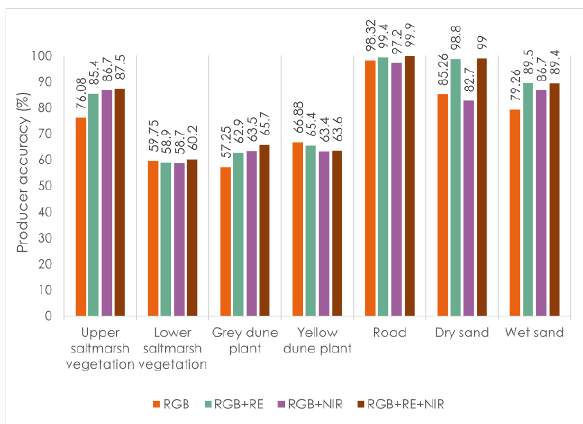
Figure 10. Barplot of producer accuracy of infrared predictors contributions on the basis RGB at class level (upper and lower saltmarsh, grey and yellow dune plant, road, dry and wet sand) computed with maximum likelihood (ML) classifier.